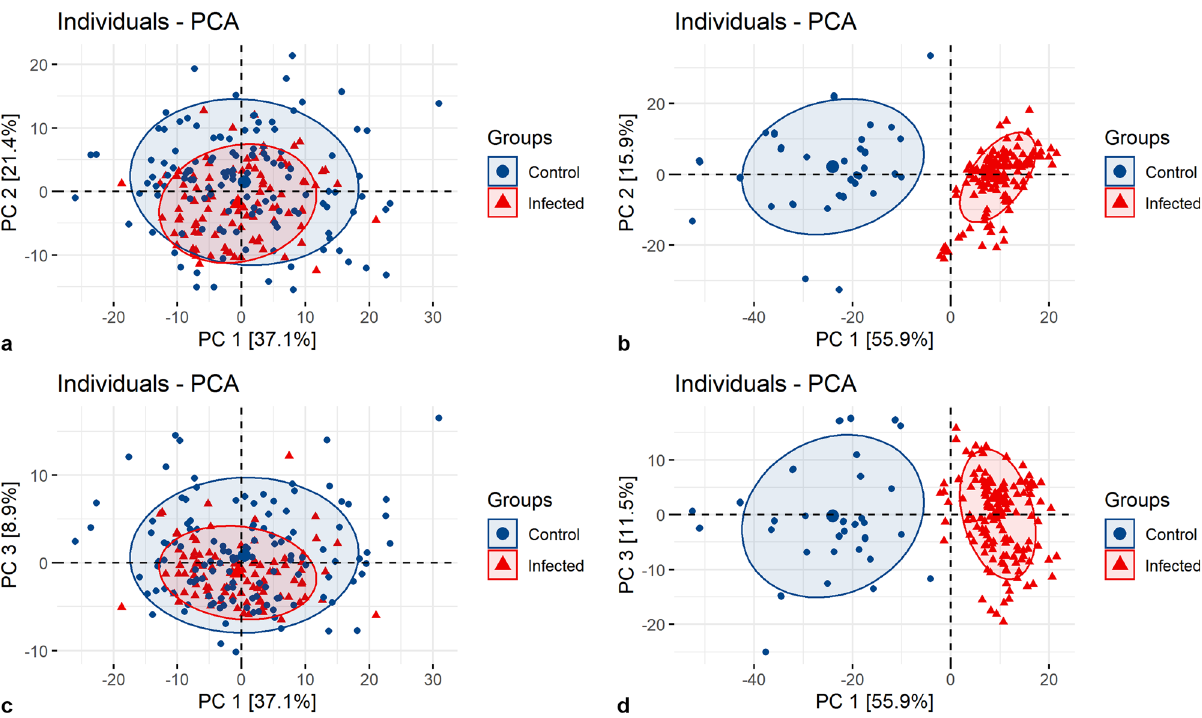
Fig. 3 PCA on spectra collected for control and infected RBCs by FTIR microspectroscopy and O-PTIR spectroscopy. PCA score plot along PC1 & PC2 and PC1 & PC3 calculated for spectra collected for control and infected RBCs by means of FTIR microspectroscopy ( a , c ) and O-PTIR spectroscopy ( b , d ).